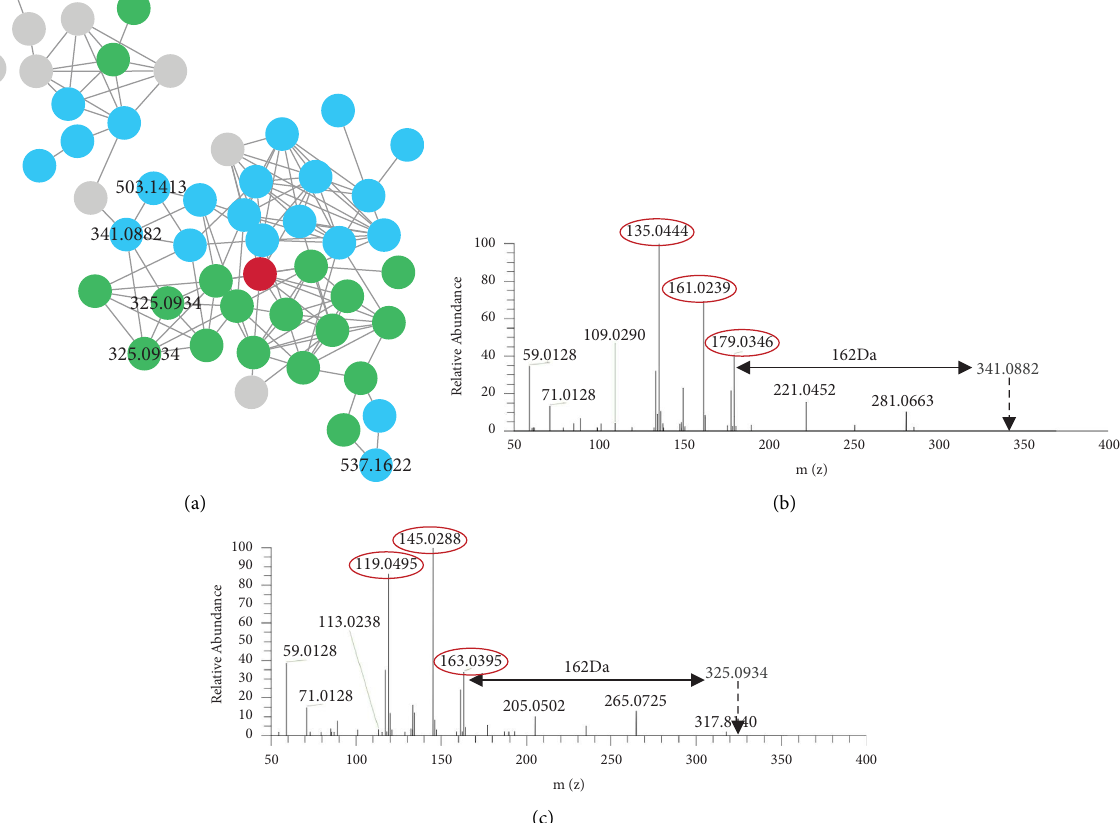
Figure 7: Molecular networking of phenolic compounds in LCP. Te nodes with green, blue and red colour represent the compounds of coumaroyl derivatives, cafeoyl derivatives, and coumaroyl-cafeoyl derivatives, respectively (a). MS/MS spectra of cafeoyl glucoside (b) and coumaroyl glucoside